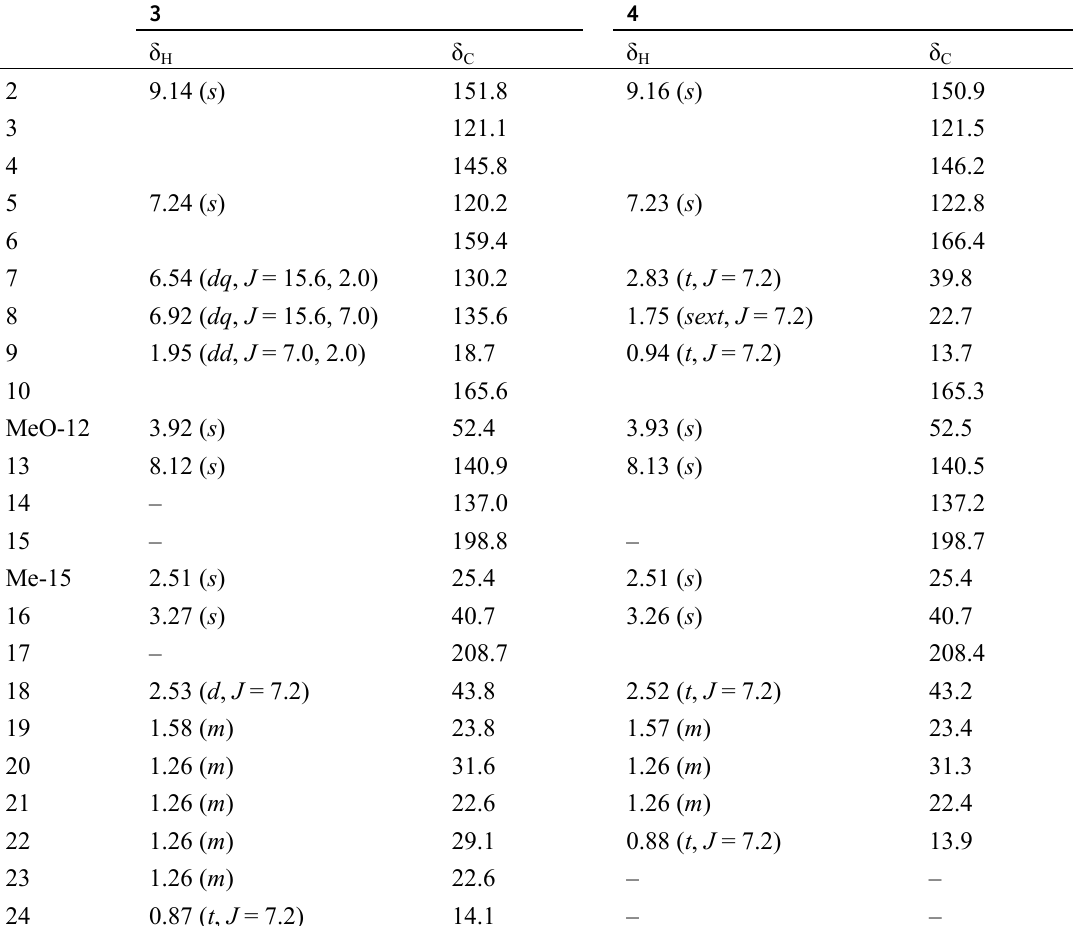
. δ in ppm, J in 3